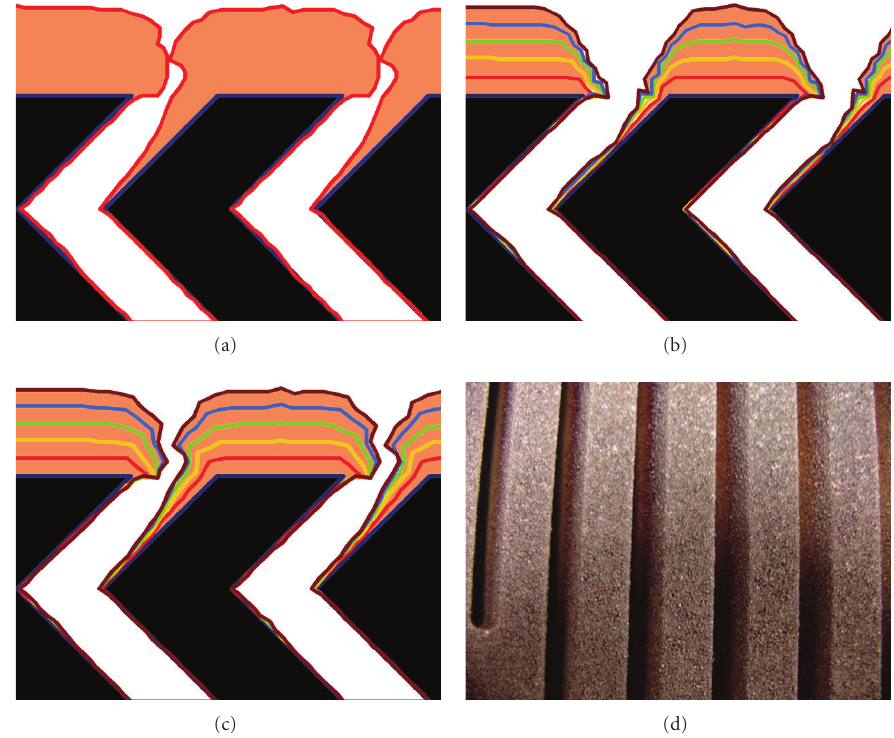
Figure 2: Simulated deposition profile of the Cu coating on the deposition ba ffl e over the period five times longer than its lifetime: (a) assumed neutrals flux only (0% Cu ionization) with no sputter etch back, the simulation was sustained up to thickness 5mm at the flat field; (b) the neutrals flux and ions flux (50% Cu ionization), assumed 10% Ar sputter etch back; and (c) neutrals flux and ions flux (85% Cu ionization), 15% Ar sputter etch back. Photo (d) illustrates the actual deposition over the half lifetime of the deposition ba ffl e.